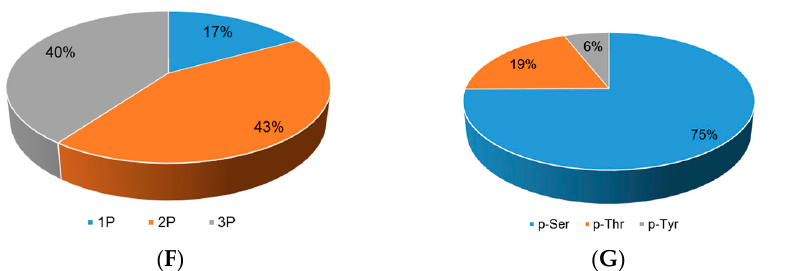
Figure 1. Characteristics of the identified unique phosphopeptides in A. mongolicus root samples. ( A ) Basic information statistics; ( B ) protein mass distribution; ( C ) unique peptide number distribution; ( D ) distribution of phosphopeptides based on their length; ( E ) protein coverage; ( F ) distribution of phosphopeptides depending on their number of phosphorylation sites (1P, one phosphorylation sites; 2P, two phosphorylation sites; 3P, three phosphorylation sites or more); and ( G ) the distribution of serine phosphorylation (p-Ser), threonine phosphorylation (p-Thr), and tyrosine phosphorylation (p-Tyr) sites in A. mongolicus roots.